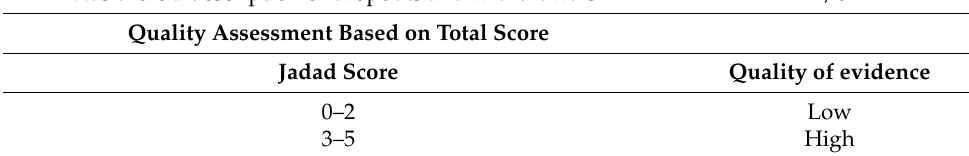
Table 9. The Jadad scoring system and the interpretation of each score. Question Yes/No Was the study described as random? 1/0 Was the randomization scheme described and appropriate? 1/0 Was the study described as double-blind? 1/0 Was the method of double-blinding appropriate? 1/0 Was there a description of dropouts and withdrawals? 1/0 Quality Assessment Based on Total Score Jadad